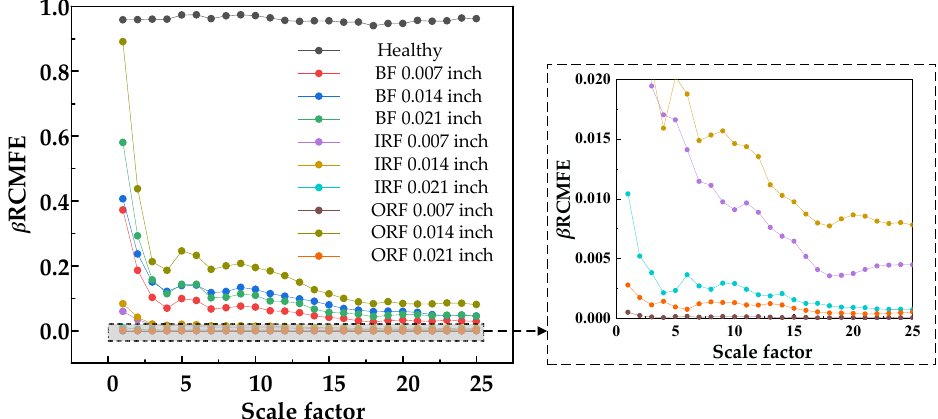
Figure 11. β RCMFE entropy values of 25 scale factors under different damage degrees.